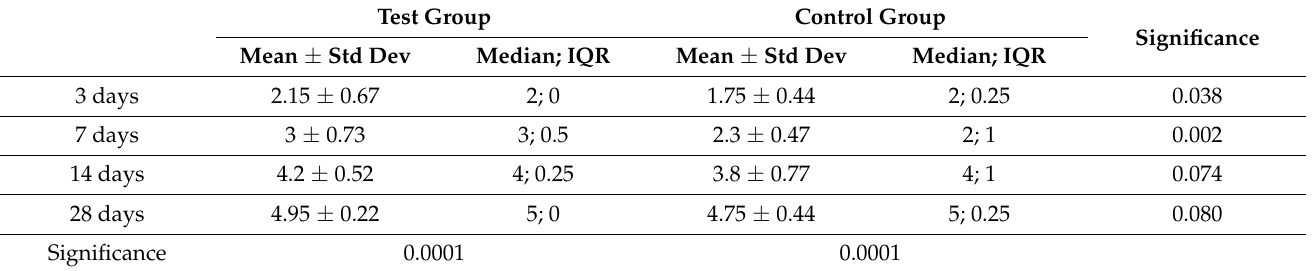
Table 3. Wound Healing Scores for both test and control groups expressed as medians and IQRs, as well as means and standard deviations.